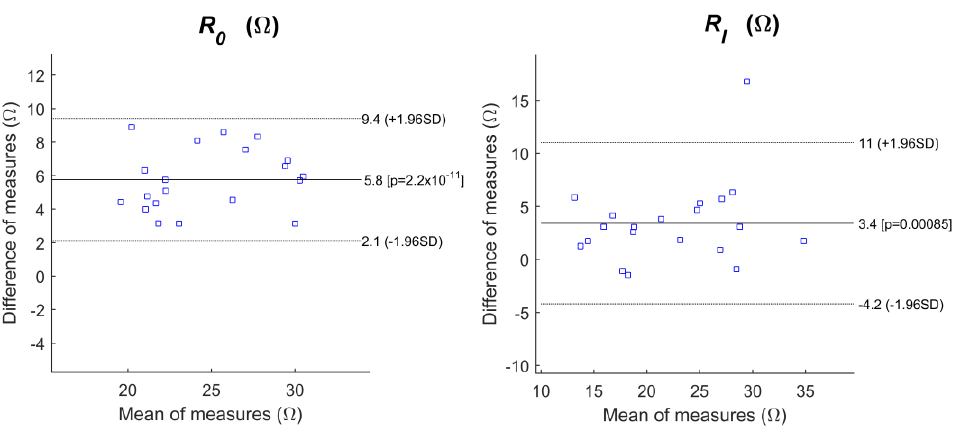
Figure 6. Bland—Altman plots for the copper mesh carbon black polydimethylsiloxane (CM/CB/PDMS) electrodes vs. textile electrodes. Left: R 0 ; right: R I .